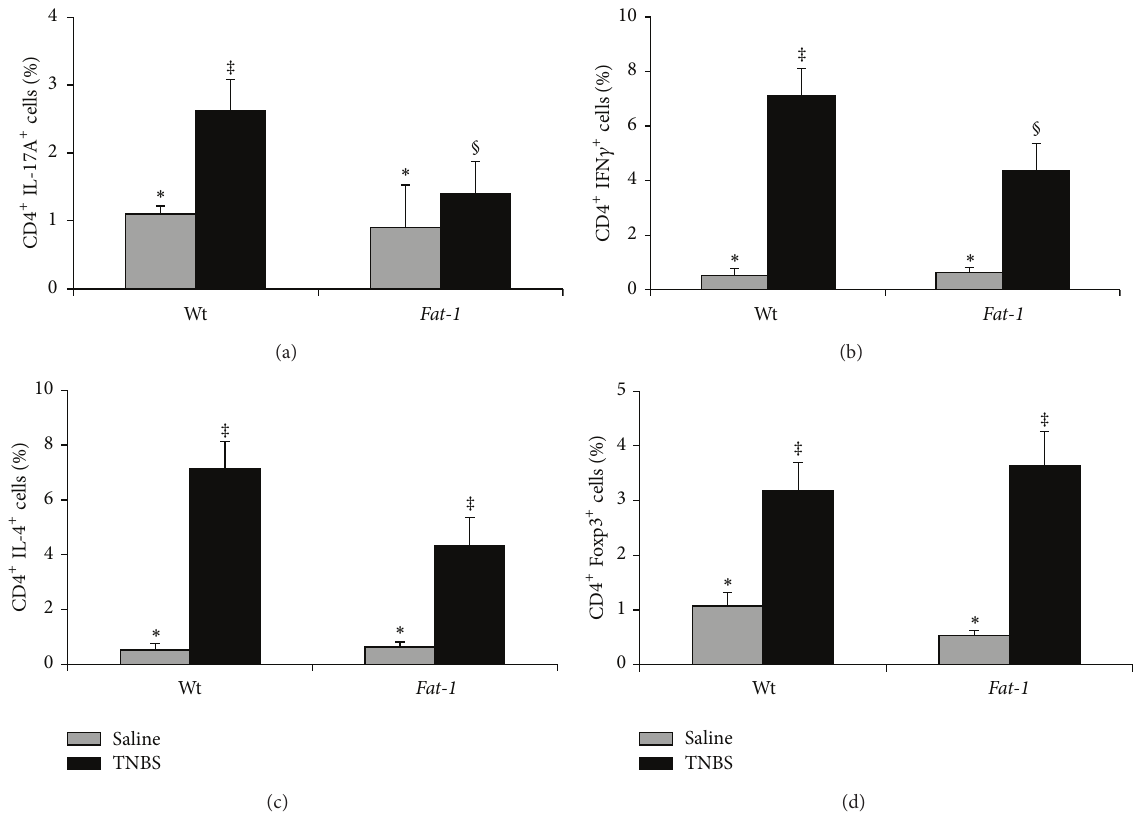
Figure 3: Percentage of mesenteric lymph node (MLN) CD4 + T cell subsets in Wt and Fat-1 TNBS-treated mice (black bars, 𝑛 = 9 –12 pooled samples/genotype comprised of 2–4 MLNs) and saline controls (grey bars, 𝑛 = 4 pooled samples/genotype). (a) Th17 cells (CD4 + IL-17A + ), (b) Th1 cells (CD4 + IFN 𝛾 + ), (c) Th2 cells (CD4 + IL-4 + ), and (d) Tregs (CD4 + Foxp3 + ). Data were analyzed by two-way ANOVA (main effects: genotype and treatment); bars represent means ± SEM. Bars not sharing a symbol differ ( 𝑃 ≤ 0.05